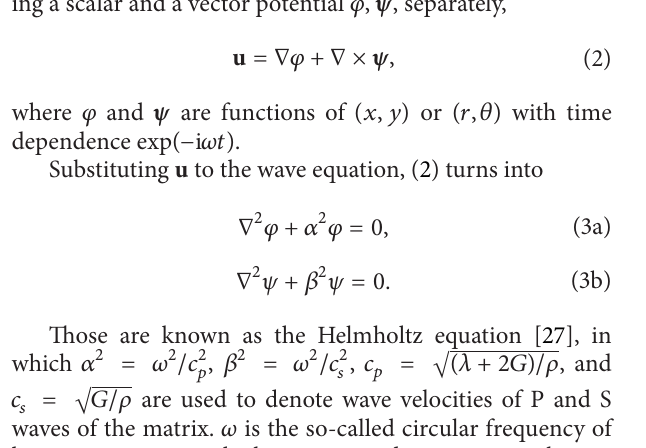
The reference coordinate system begins with the origin 0 and is set up as a rectangular Cartesian coordinate (𝑥, 𝑦) or a polar coordinate (𝑟, 𝜃) . The first tubular pile above the x -axis is defined as number 0; the next ones are identified by the numbers 𝑠 , 𝑠 󸀠 , 𝑠 󸀠󸀠 , and so forth. The piles are with the external radii 𝑎 , 𝑎 𝑠 , and 𝑎 𝑠 󸀠 and internal radii 𝑏 , 𝑏 𝑠 , and 𝑏 𝑠 󸀠 , respectively. The point 𝑃 stands for an arbitrary position with respect to the origin. The distances between point 𝑃 and pile-centers are 𝑟 , 𝑟 𝑟 𝑠 , 𝑠𝑠 󸀠 and so forth; the angles independent of each cylinder are 𝜃 , 𝜃 𝑠 , 𝜃 𝑠𝑠 󸀠 and so forth; their center-to-center spaces are 𝑟 𝑟 𝑟 0𝑠 , 𝑠𝑠 , 𝑠𝑠 󸀠 and so